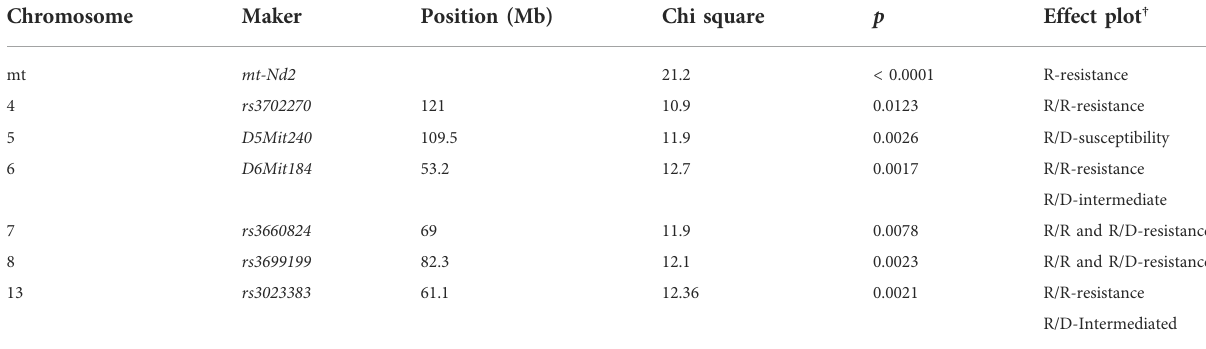
† For effect plot R indicates the ALR, allele and D indicates the NOD,